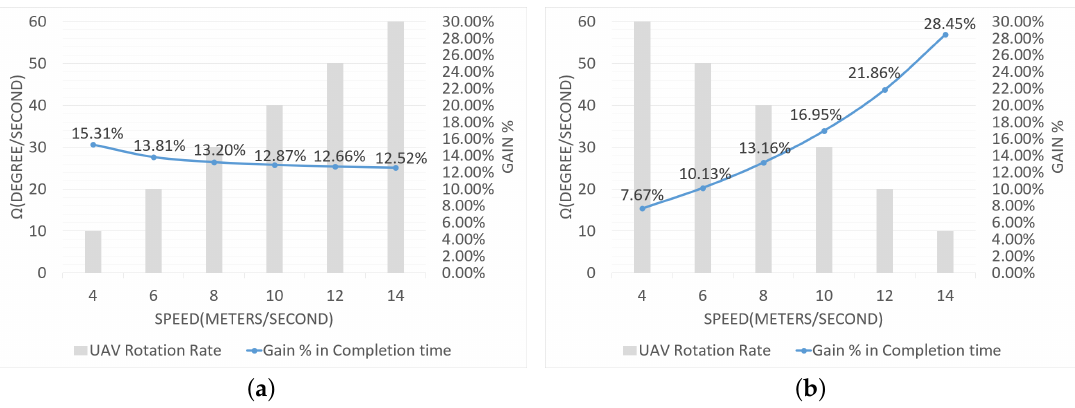
Figure 19. Gain in completion time in EAOA compared to the basic approach. ( a ) gain in completion time while increasing both the speed and rotation rate; ( b ) gain in completion time while increasing the speed and decreasing the rotation